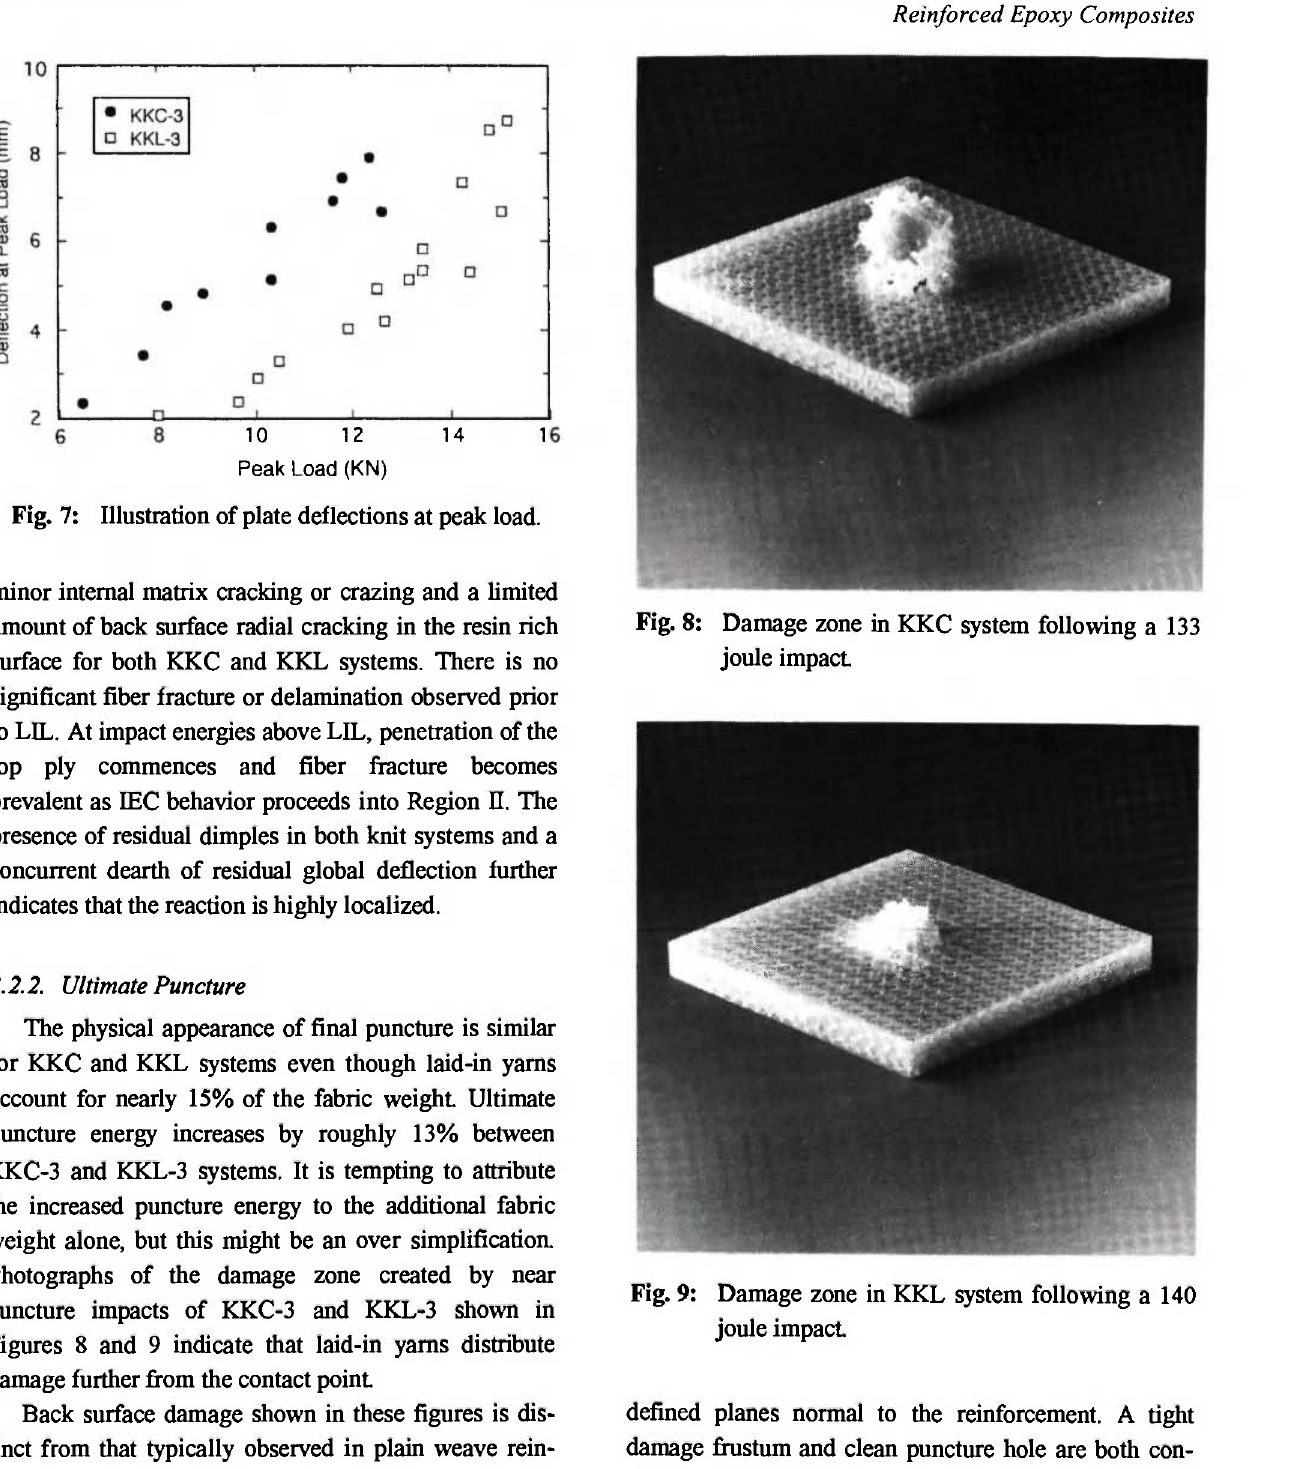
Fig. 9: Damage zone in KKL system following a 140 joule